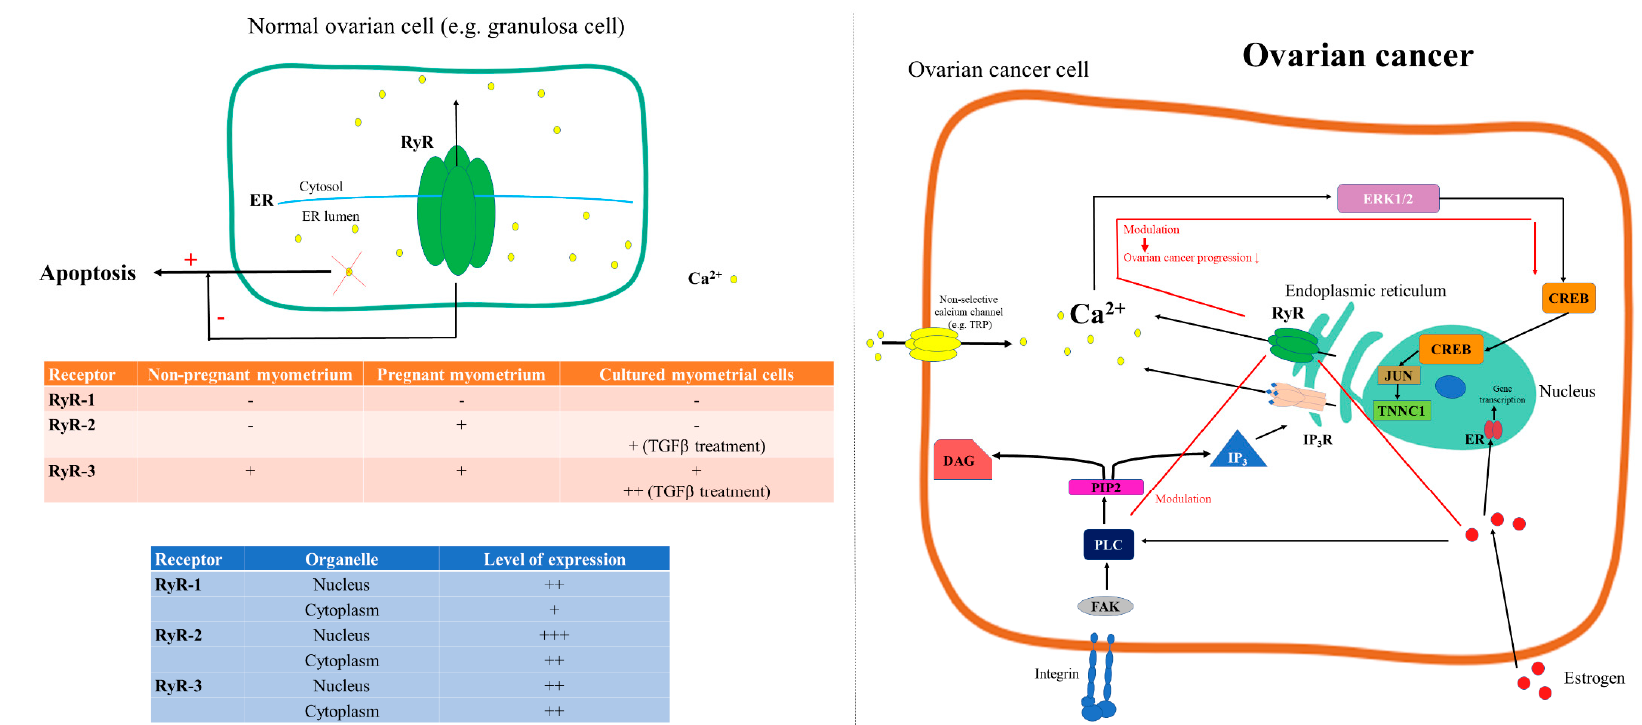
Figure 3. RyR-mediated Ca 2 + signaling in ovarian physiology and cancer. RyR1 expression was not evidenced in either non-pregnant and pregnant myometrium nor in cultured myometrial cells. Meanwhile, RyR2 are expressed only in pregnant myometrium, and RyR3 are expressed both in non-pregnant and pregnant myometrium. Cultured myometrial cells express only RyR3, and TGF- β treatment upregulates both RyR2 and RyR3. Distinct subcellular expression of RyR subtypes was evidenced [81]. Persistent depletion of the ER Ca 2 + deposits promotes apoptosis ( + ), while RyR inhibits ( − ) apoptotic cell death [122]. In ovarian cancer, RyR may contribute to the reduction of cancer progression by modulating the FAK // CREB / TNNC1 signaling pathway [127] and may modulate the ER α –PLC γ –IP 3 R pathway [128] (red